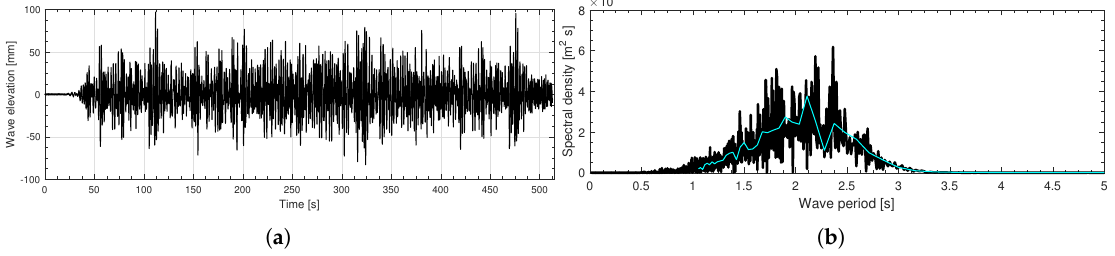
Figure 5. Random incoming wave ( a ) elevation time series, ( b ) spectral